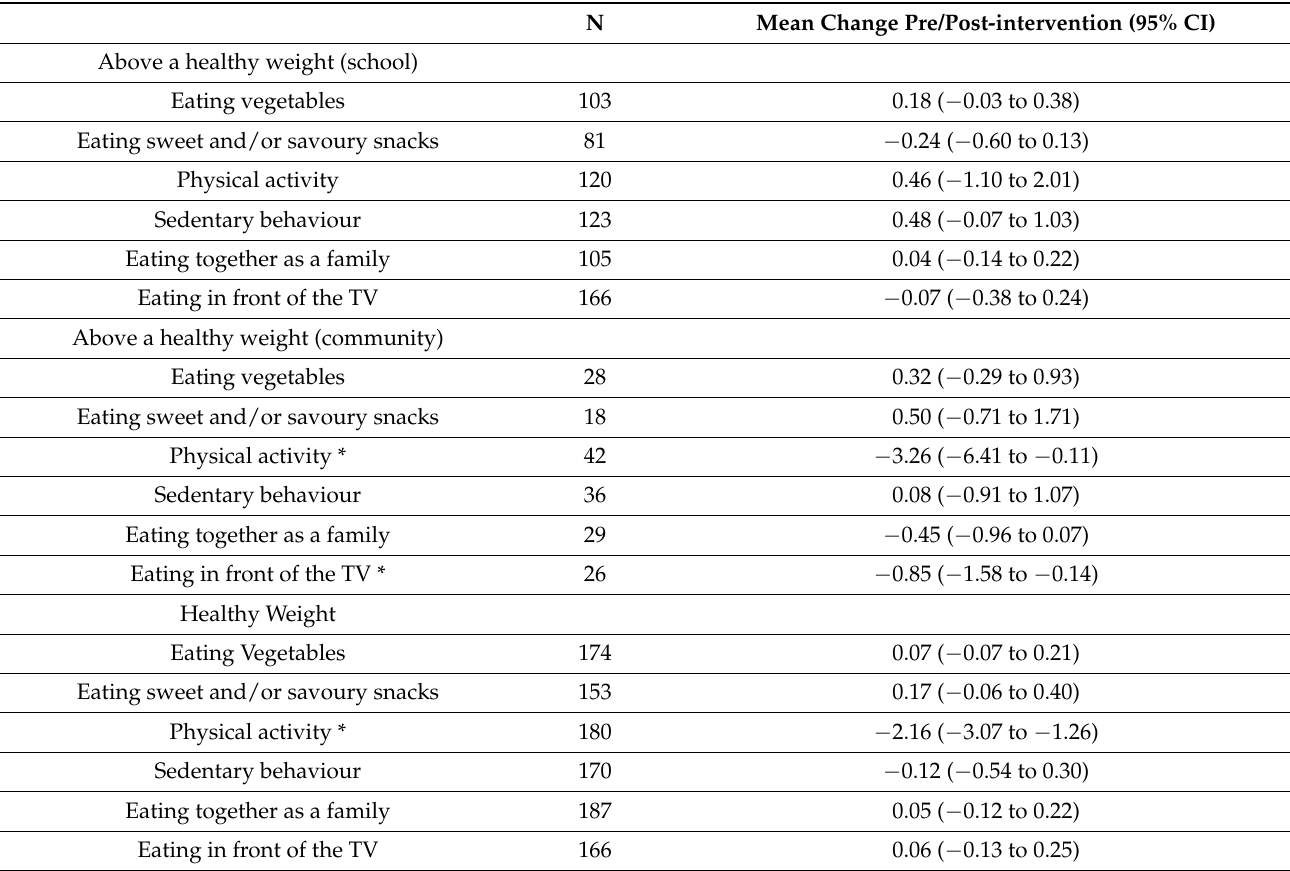
Table 5. Mean change in health behaviours from baseline to post-intervention, by baseline BMI z-score and setting. N Mean Change Pre/Post-intervention (95% CI) Above a healthy weight (school) 103 0.18 ( − 0.03 to